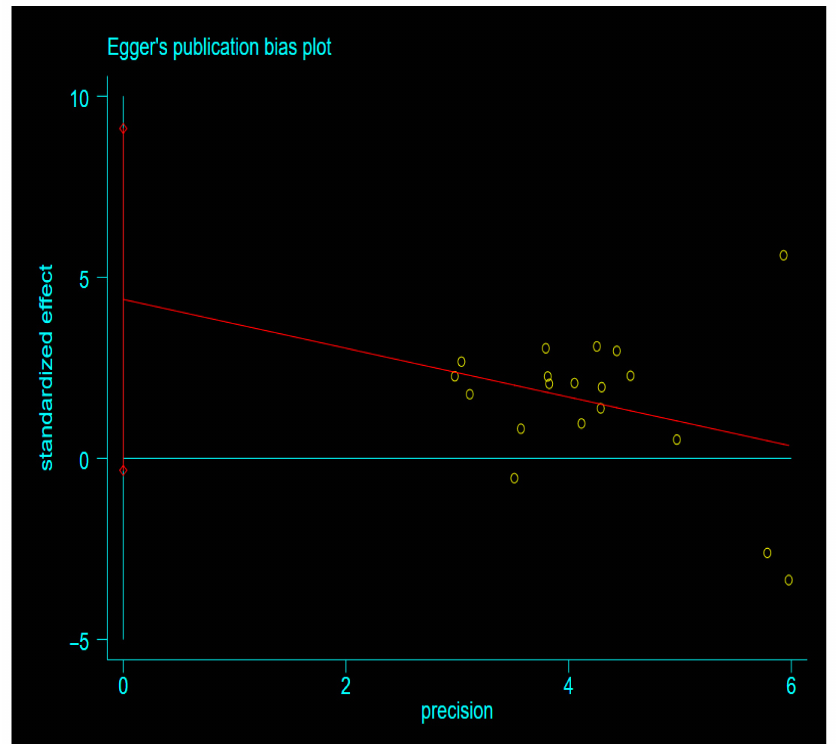
Figure A2. Quantitative analysis of publication bias using Egger’s linear regression method.